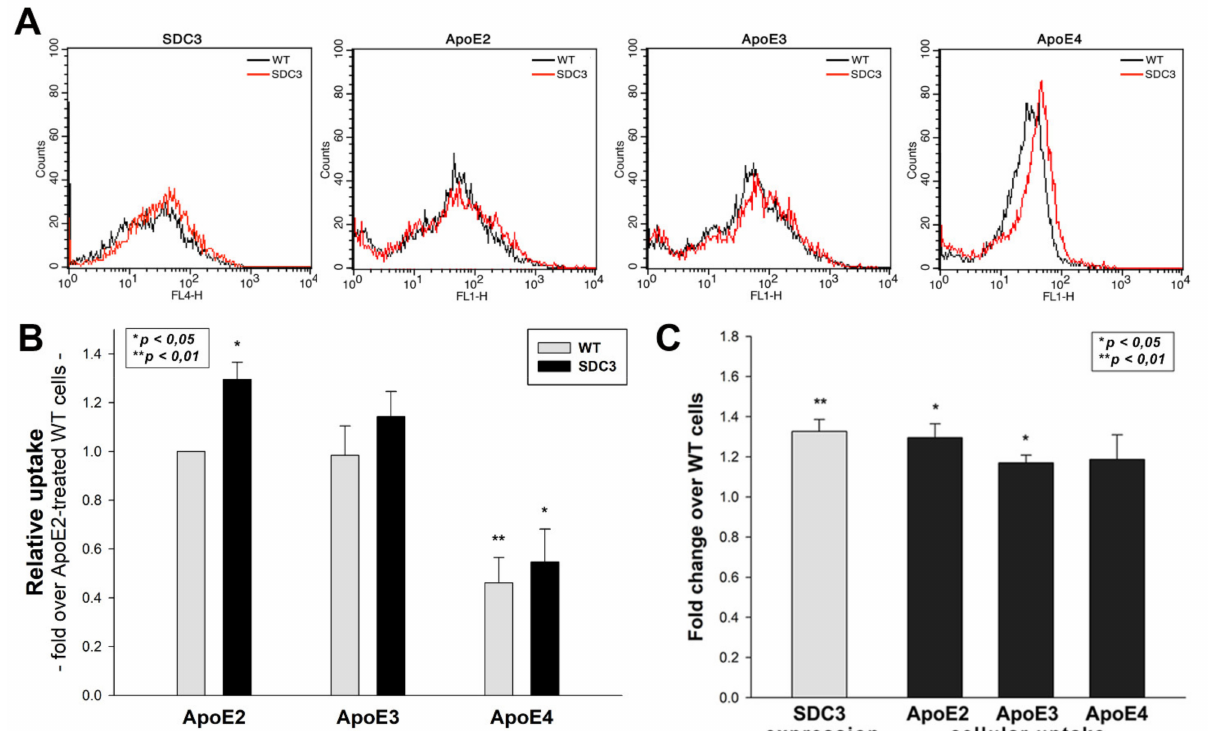
Figure 4. SDC3 overexpression increases ApoE uptake into SH-SY5Y cells. SDC3-overexpressing clones created in differentiated SH-SY5Y cells were selected by measuring SDC3 expression with flow cytometry. ( A ) Flow cytometry histograms representing SDC3 expression levels and intracellular fluorescence of FITC-ApoE-treated differentiated WT SH-SY5Y cells and SDC3 transfectants, created in differentiated SH-SY5Y cells. SDC3 transfectants and WT SH-SY5Y cells were treated with FITC-labeled ApoEs at 37 ◦ C for 3 h and then processed for uptake studies. ( B ) Detected intracellular fluorescence intensities were normalized to FITC-ApoE2-treated WT SH-SY5Y cells as standards. The bars represent the mean ± SEM of three independent experiments. Statistical significance vs. standards was assessed with ANOVA. ( C ) Fold change in SDC3 expression, along with ApoE uptake following SDC3 overexpression in differentiated SH-SY5Y cells. The bars represent the mean ± SEM of three independent experiments. The statistical significance vs. ApoE2-treated WT SH-SY5Y cells as standards was assessed with ANOVA. * p < 0.05; ** p <